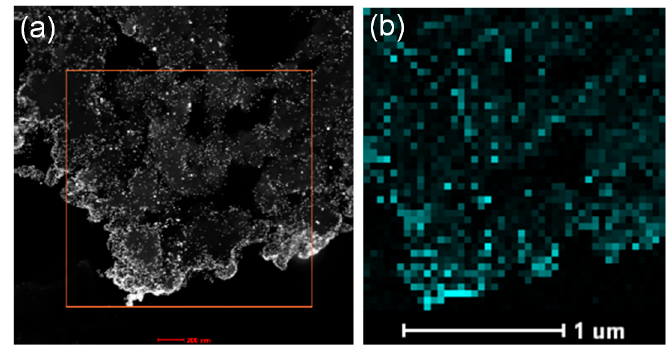
Figure 7. ( a ) STEM image of AuNP-WP sample from 0.6 mM of Au ions and ( b ) elemental mapping of Au from a region marked by a box in (a).